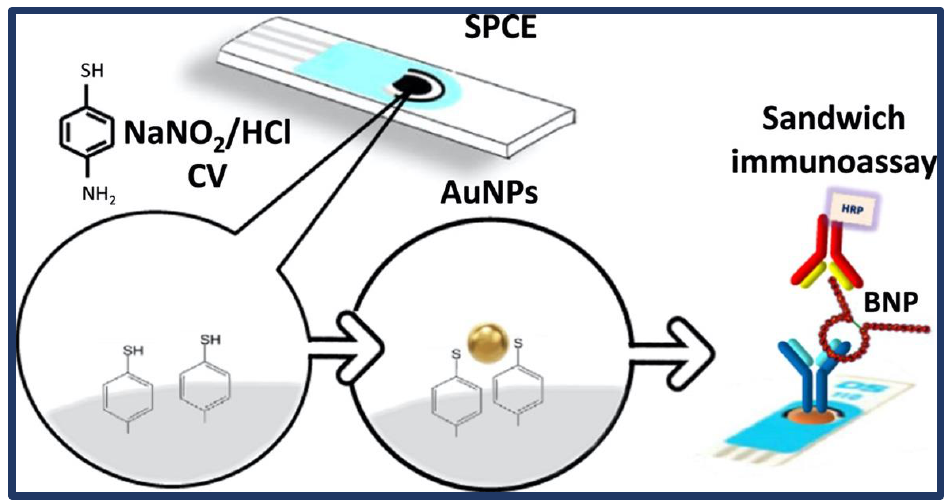
Figure 7. Schematic representation of fabricated B-type natriuretic peptide (BNP)-sensing biosensor. Reprinted from Ref. [64] with permission from Elsevier.